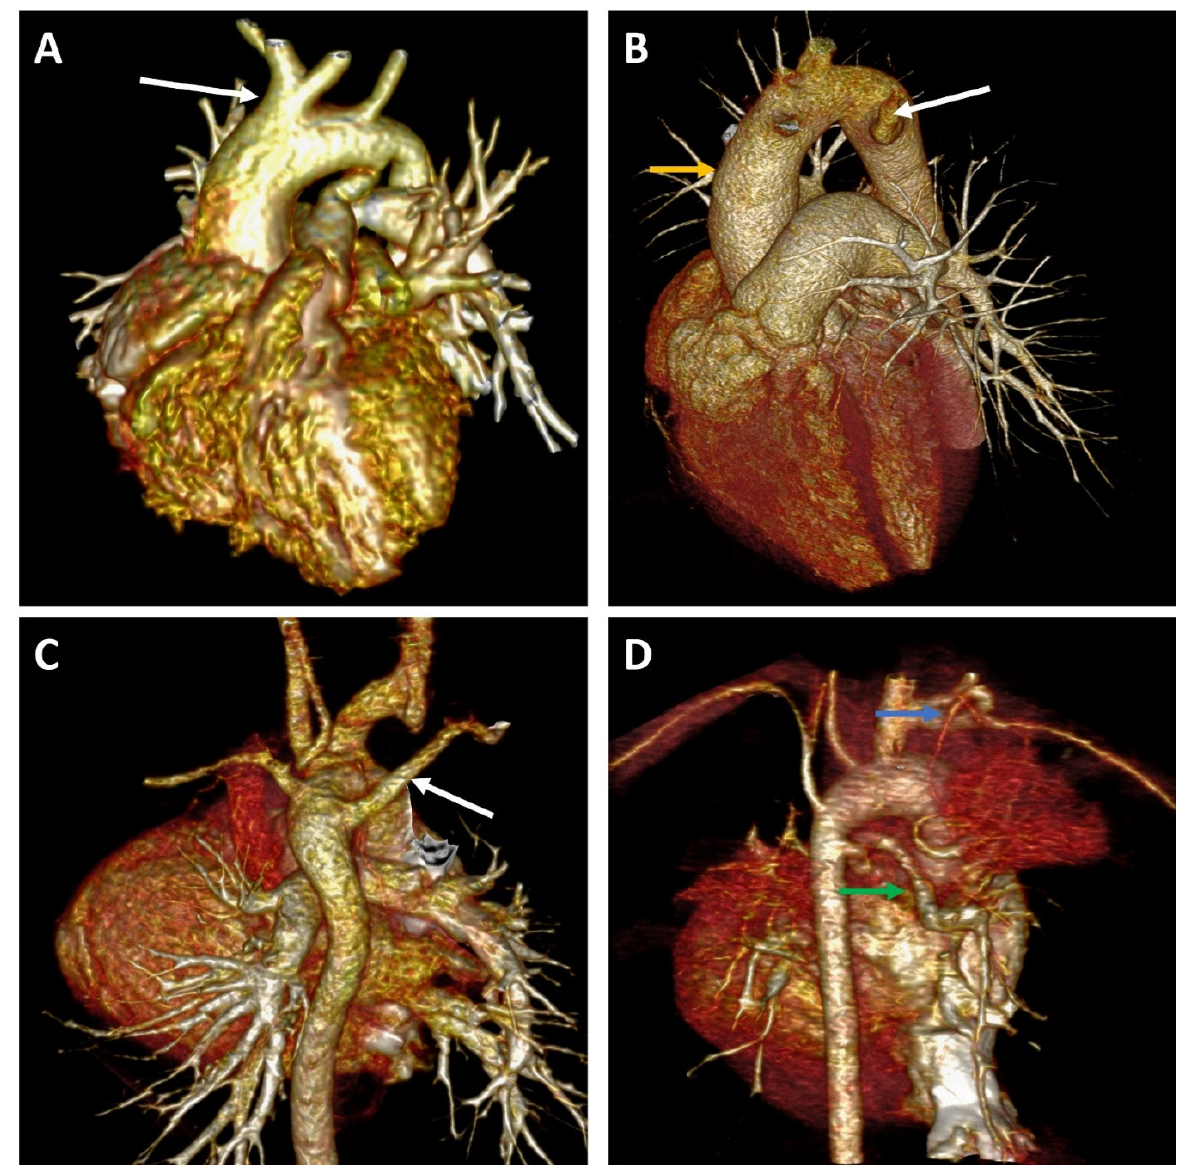
Figure 2. Representative image for aortic arc anomalies. ( A ) Left-sided aortic arch with left carotid artery from brachiocephalic trunk (“bovine arch”). ( B ) Right-sided aortic arch (yellow arrow) with anomalous left subclavian artery (white arrow). ( C ) Left-sided aortic arch with aberrant right subclavian artery (white arrow). ( D ) Major aortopulmonary collateral arteries (MAPCAs) feeding the left pulmonary artery (green arrow) and the apical portion of the left upper lobe (blue arrow).